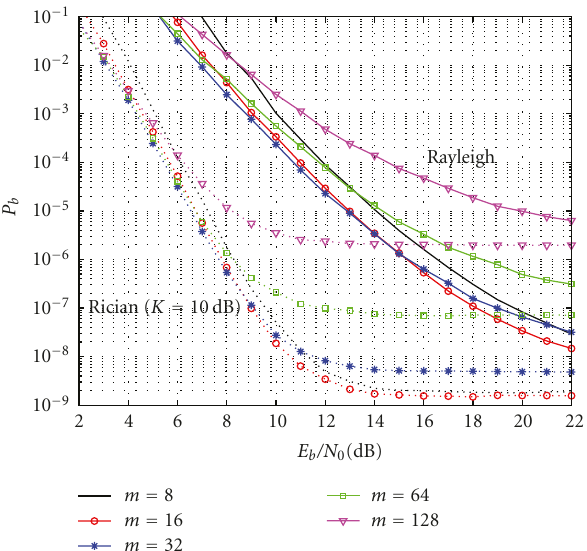
Figure 8: Performance of a convolutionally coded FHSS system over Rayleigh and Rician fading channels with an OPE receiver for number of users K = 20, SIR = 5dB, and di ff erent hop lengths m = 8,16,32,64,128, (solid: Rayleigh, dashed: Rician with κ = 10dB).